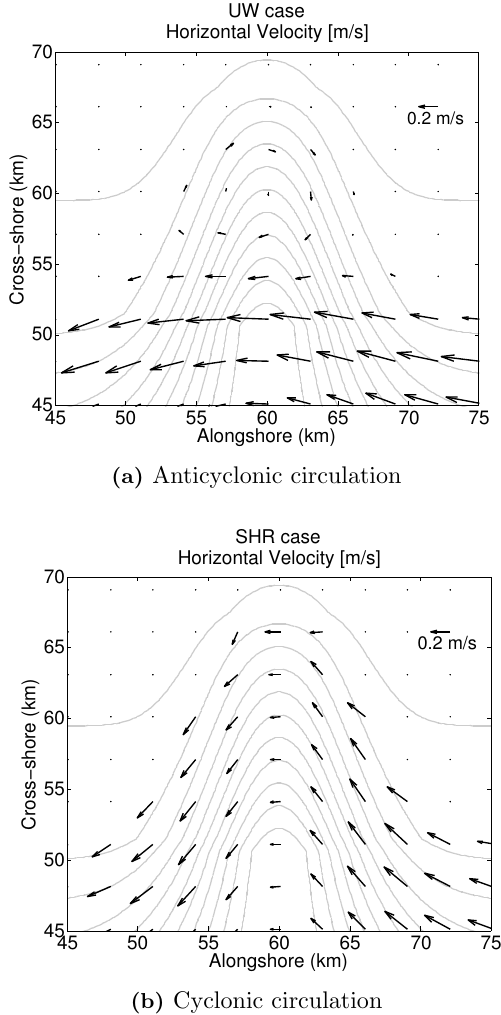
Figure 6. Horizontal velocity vectors at shelf break depth (150m) in (a) simulation with anticyclonic circulation (UW) and (b) sim- ulation with cyclonic circulation (SHR). Vectors are averaged over a period of 3 model days during the advection phase (model days